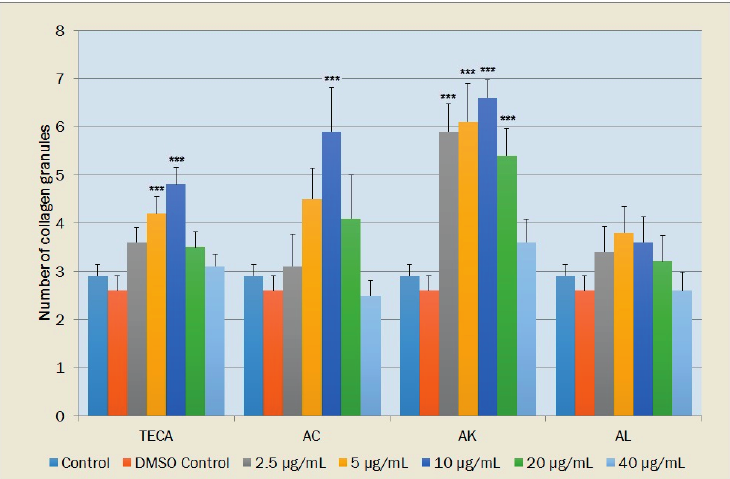
Figure 8. Effects of TECA, AC, AK and AL extracts on the number of collagen granules in NIH-3T3 fibroblasts. Data are mean ± SEM values ( n = 10 in each case). *** p < 0.001, significantly different from control